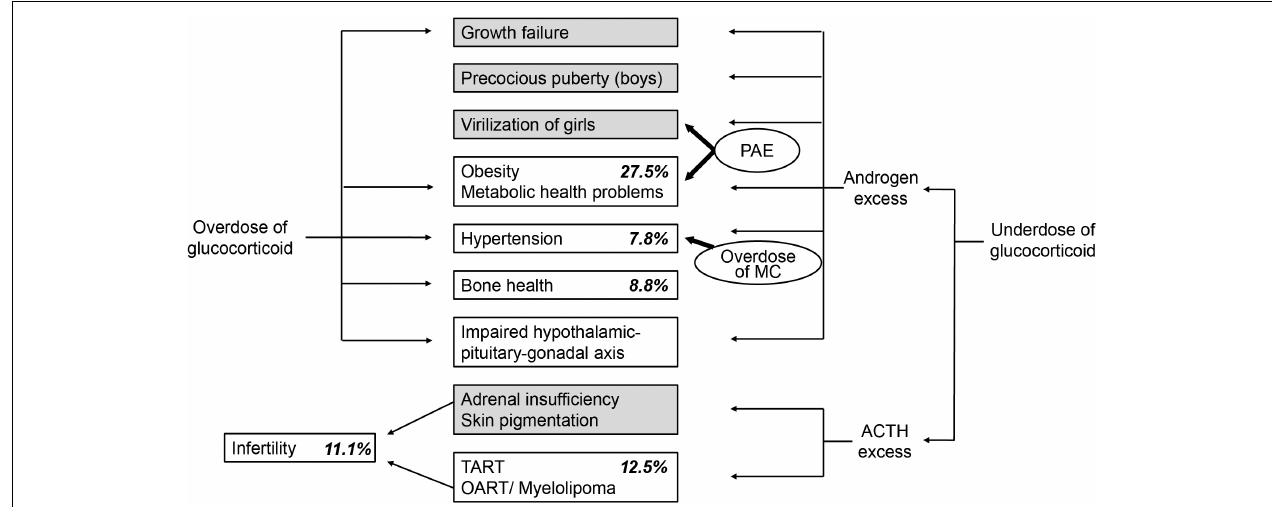
FIGURE 1 | Endocrine imbalances in 21-hydroxylase deficiency (21-OHD) (18) and long-term complications of adult patients with 21-OHD treated in pediatrics in Japan (24). Italic indicates the prevalence of long-term complications of adult patients with 21-OHD treated in pediatrics in Japan. Gray boxes indicate complications that mainly draw the attention of pediatric endocrinologists. PAE, prenatal androgen excess; MC, mineralocorticoid; ACTH, adrenocorticotropic hormone; TART, testicular adrenal rest tumor; OART, ovarian adrenal rest tumor.